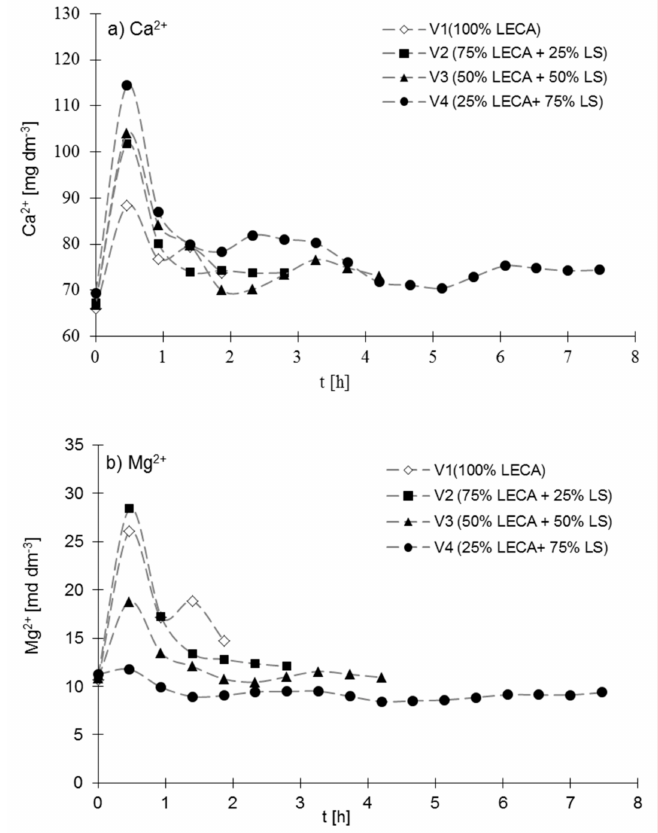
Figure 4. Concentrations of Ca 2+ ( a ) and Mg 2+ ( b ) in the hypolimnetic water during the treatments on the column beds (LS: limestone); dashed lines were used for better visibility of the trend. Results were presented for the time of effective sorption (OP removal rate of ≥ 10 ±